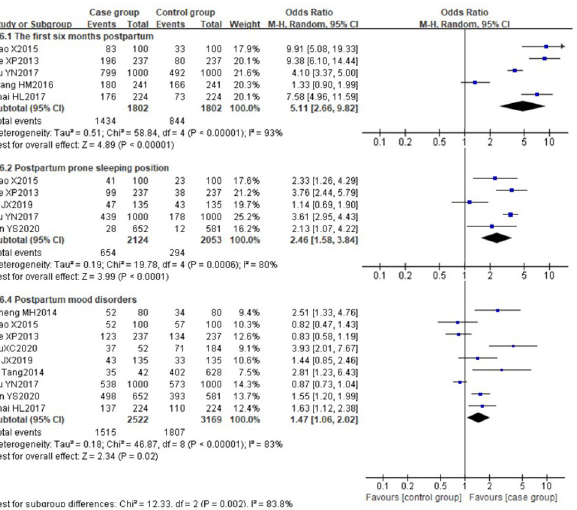
Fig 7. Forest plot comparing the pooled risks of the first six months postpartum, postpartum prone sleeping position and postpartum mood disorders.